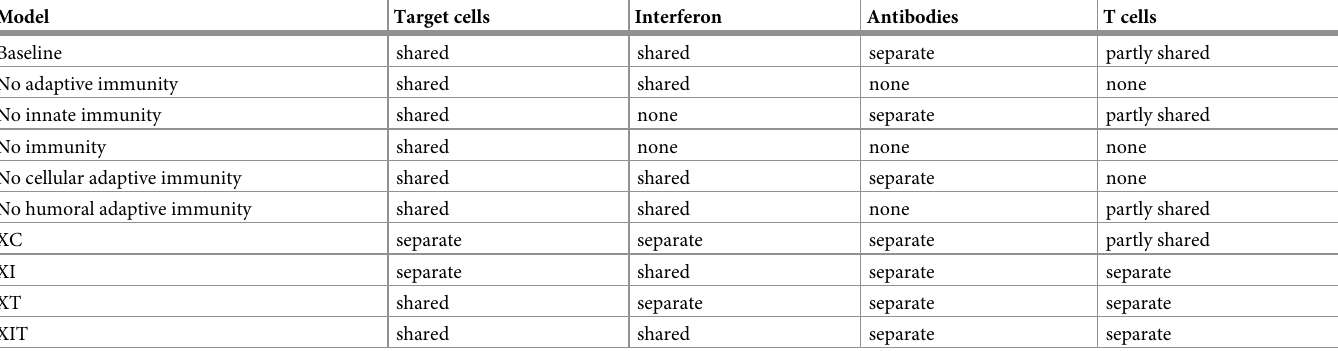
Table 1. Summary of model modifications for